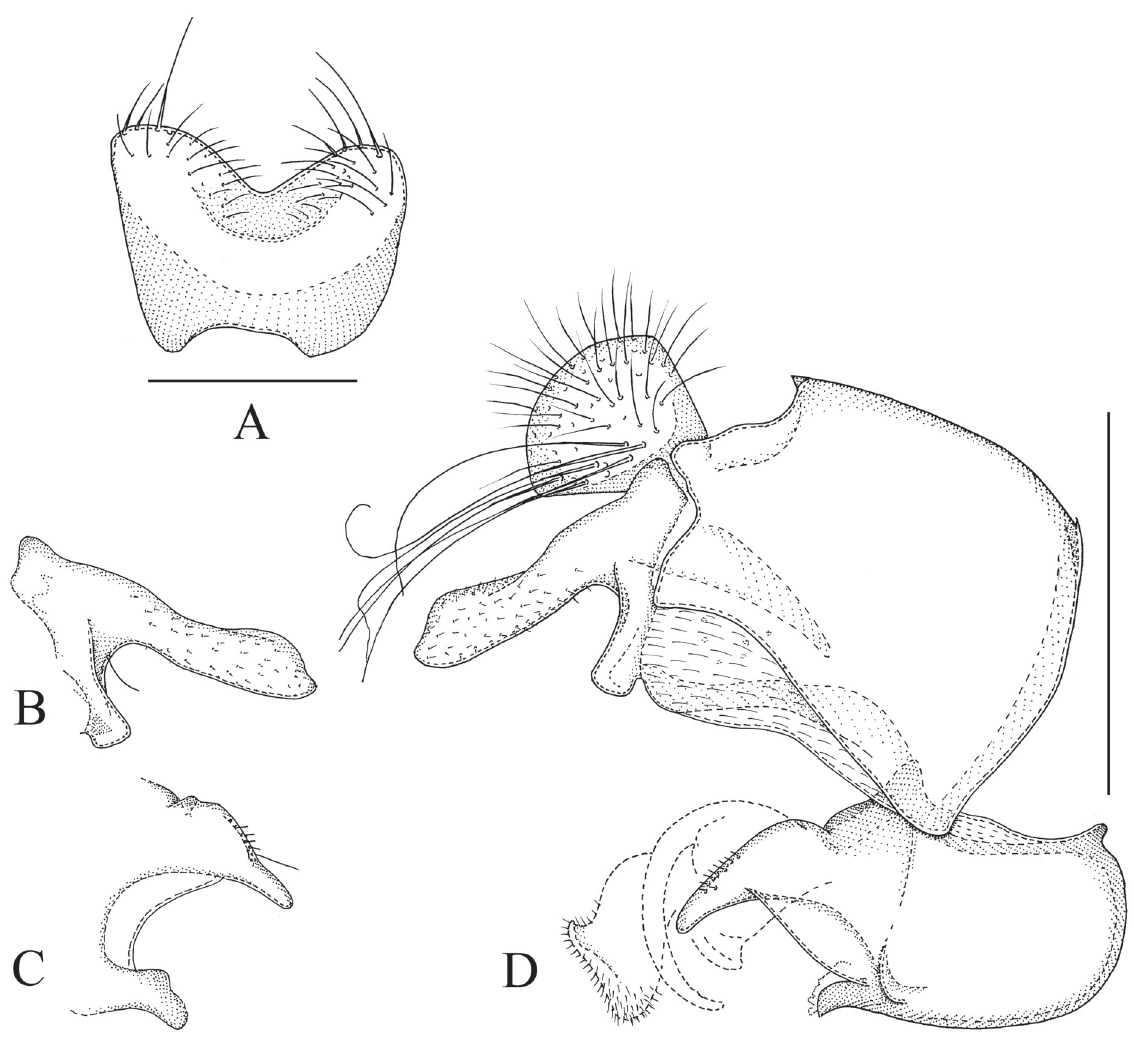
right side, lateral view. Scale bars = 0.5